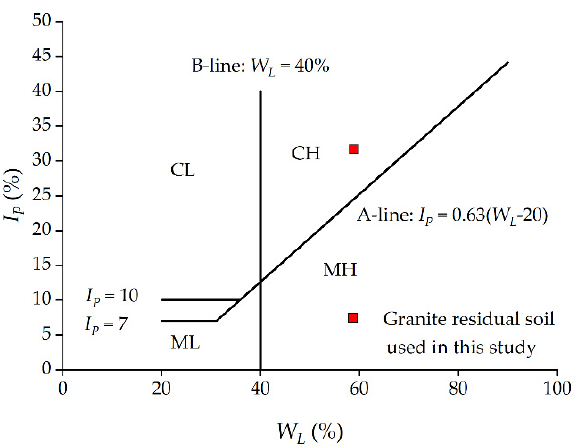
Figure 3. Position of the granite residual soil in the Casagrande plasticity chart.